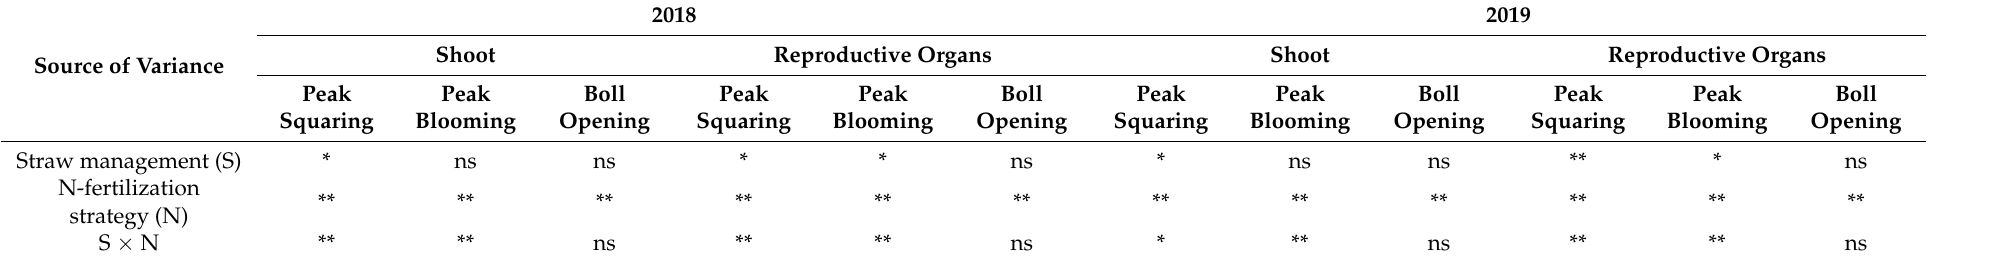
Table 3. Sources of variance in variance analysis of N